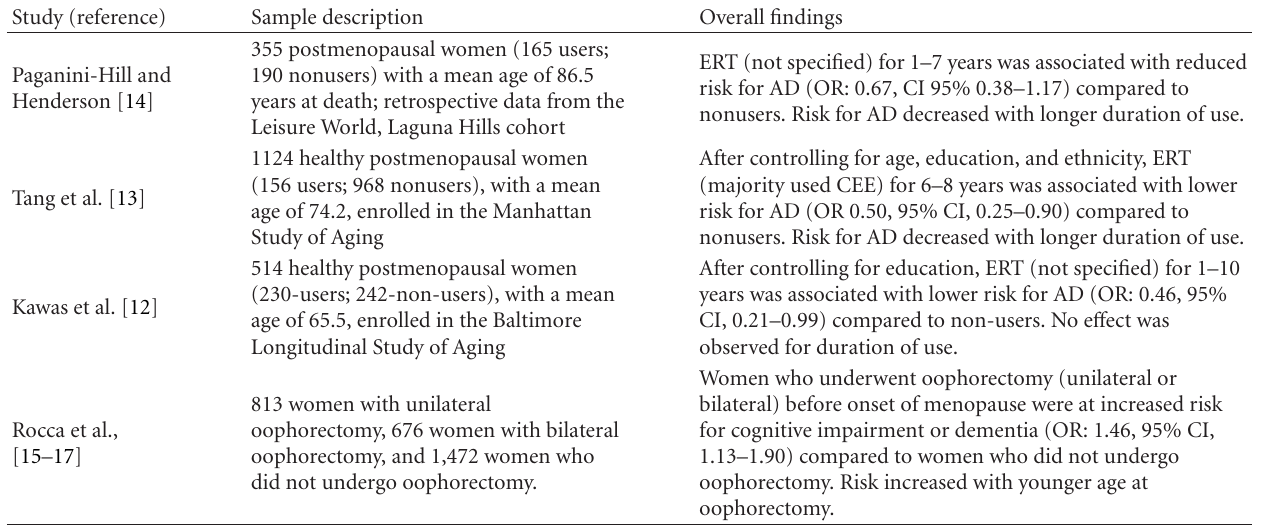
Table 1: Observational studies of ERT and risk for